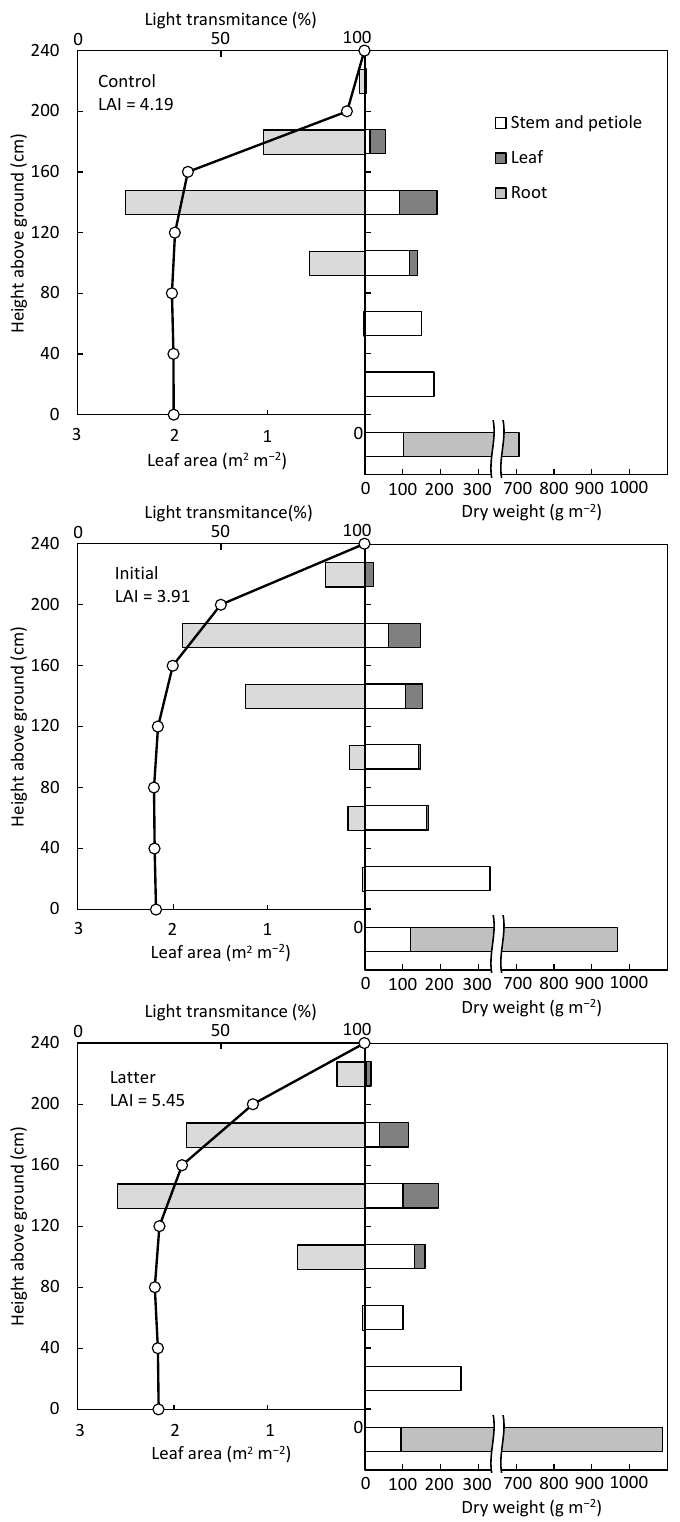
Figure 8. Light transmittance rate ( ○ ), leaf area, and dry matter distribution of the control, initial, and latter fertilization treatments.